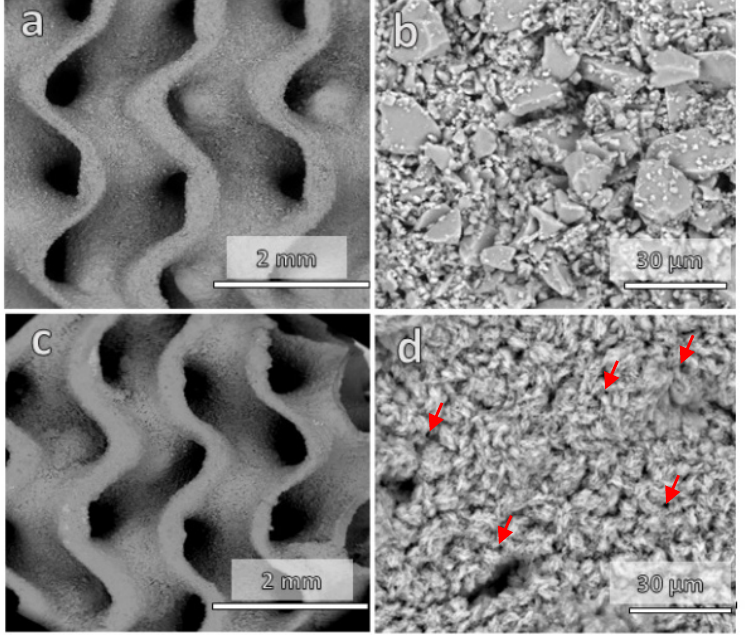
Figure 5. Microstructural details of activated gyroid scaffolds: ( a , b ) fired at 680 °C; ( c , d ) fired at 730 °C.